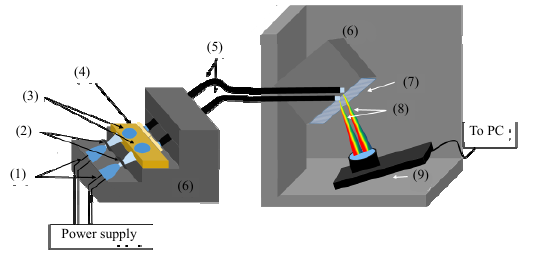
Fig. 6 Multichannel SPR system and multichannel spectrometer design.